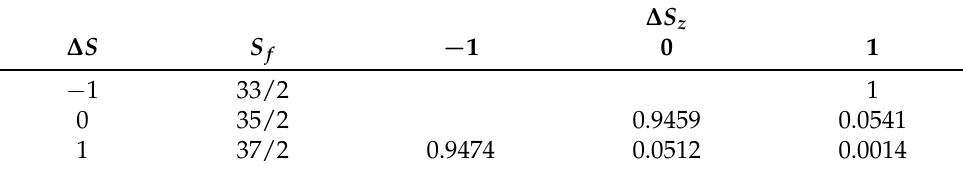
Table 5. Intensity ratios for the magnetic dipole transitions from a ground state level ( S , S z ) = (35/2, − 35/2) to the three possible excited spin states with spin S f . Note that the intensity ratios only apply to the different ∆ S z transitions within a given multiplet. Comparing the intensities between different multiplets requires knowledge of their respective reduced matrix